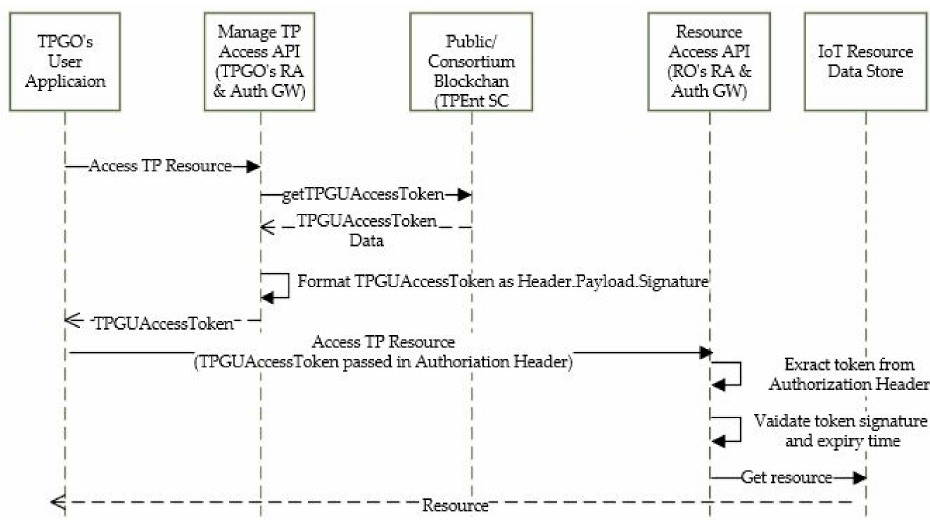
Figure 8. Accessing external TP